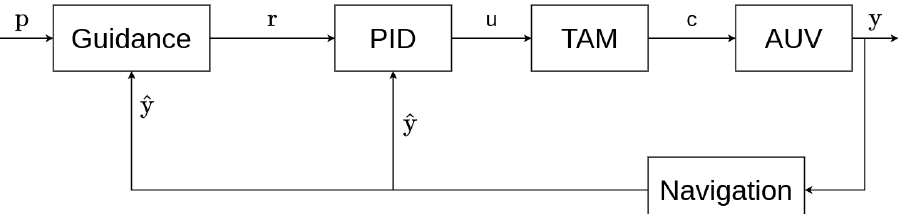
Figure 8. The GNC system with the PID as the controller and the addition of the thruster allocation matrix